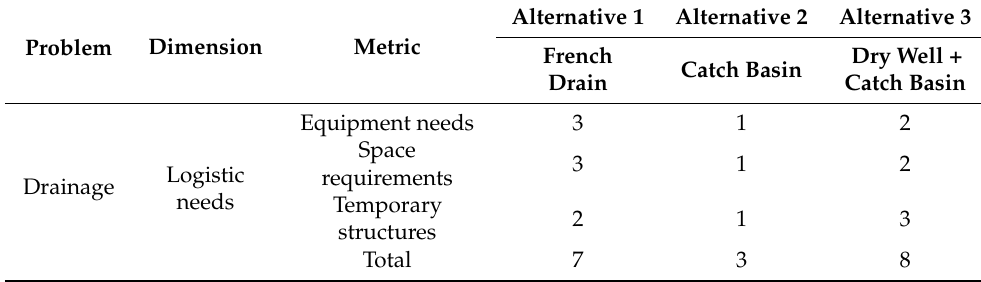
Table 7. Technical/design analysis—logistic